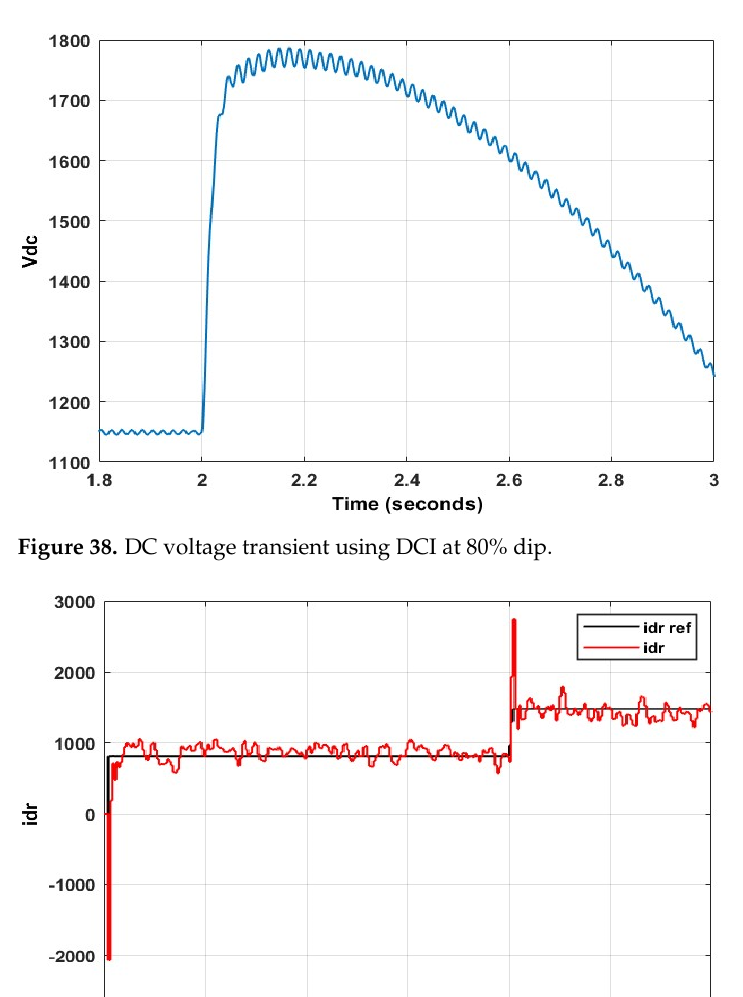
Figure 40. Rotor direct axis current average using DCI at 80% dip.